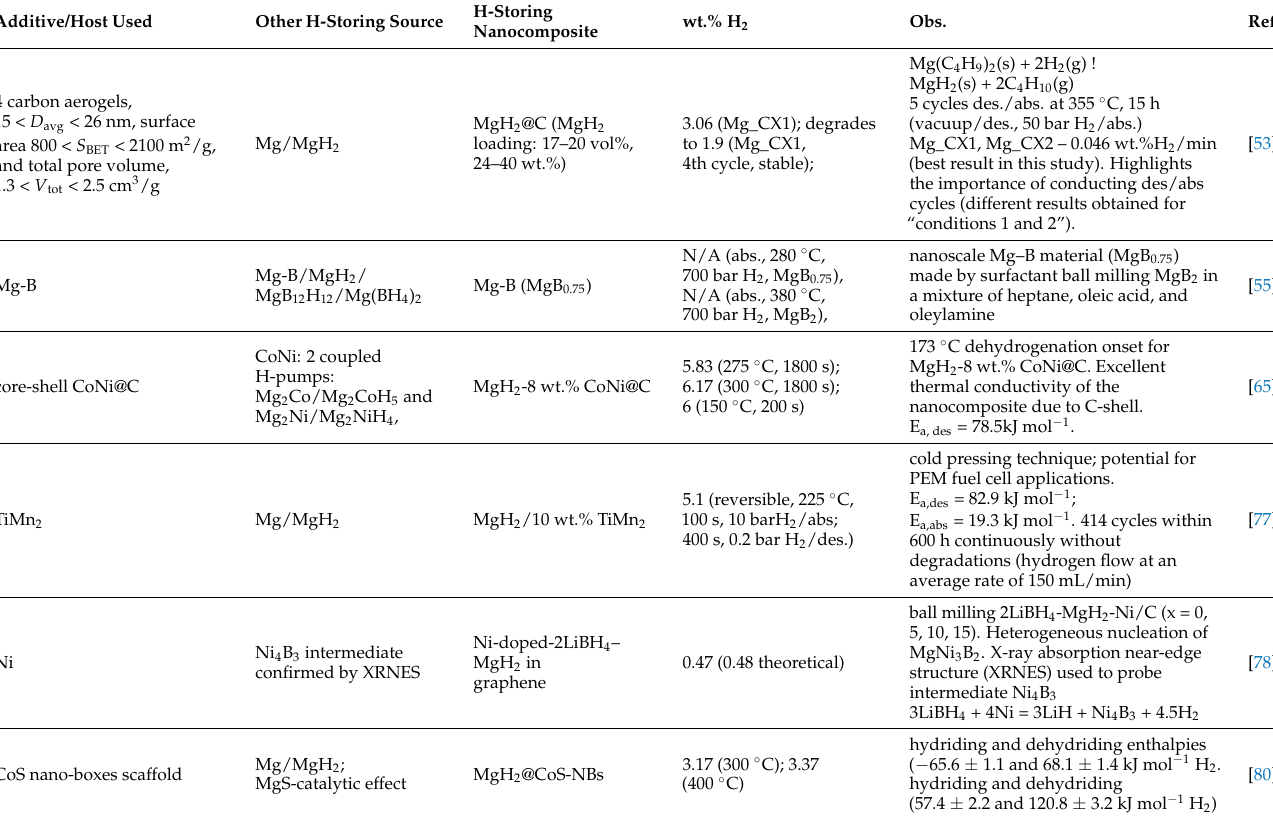
Table 11. Hydrogen storage features of nanosized MgH 2 -based